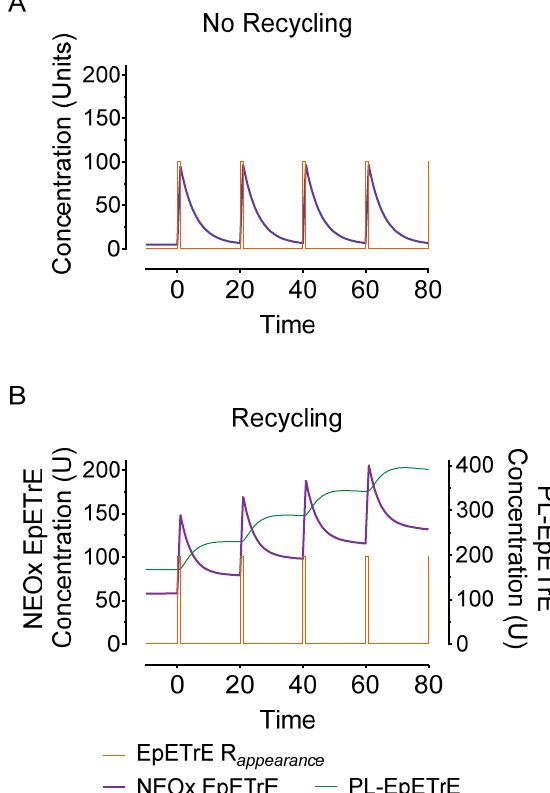
Figure 4. Effect of repeated stimuli on non-recycling (model A ) and recycling systems (model B ). To illustrate the impact of successive intervals of EpETrE appearance, the simulations in Figure 3 were modified to simulate repeated pulsed appearance of EpETrE (100 U over 1 min) every 20 min (EpETrE R appearance ). This feature demonstrates how a recycling system (model B ) is better organized for signal amplification in response to successive stimuli. As in Figure 3, concentrations are in arbitrary units (U).